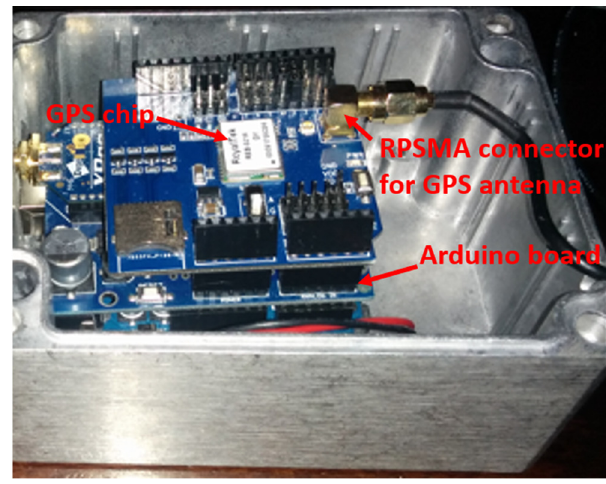
Figure 5. The embedded GPS system on the train.